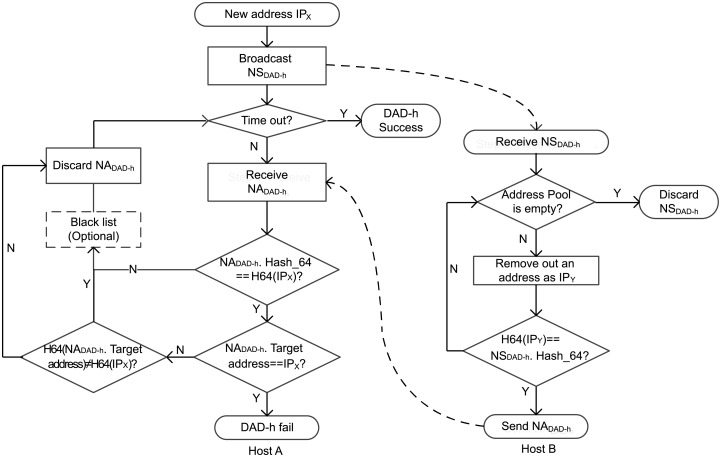
Flowchart of DAD-h.